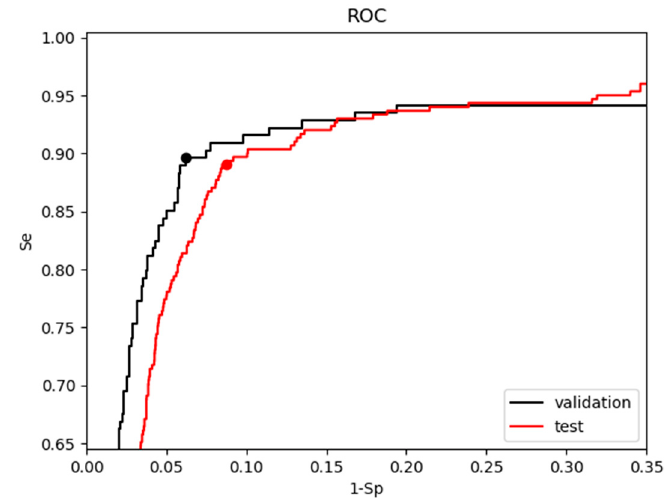
Figure 6. Training process of CNN3-CC-ECG network run over 400 epochs, showing the accuracy ( a ) and loss ( b ) curves for the training and validation dataset. The best model (validation accuracy → max) was achieved in 213 epochs. Further training epochs were discarded as being ineffective (gray area).